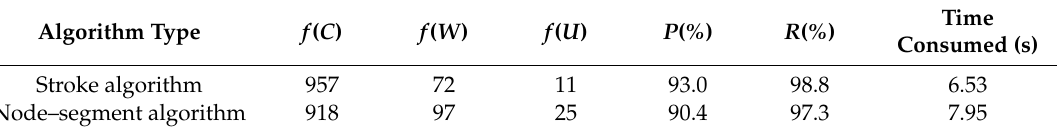
Table 4. Comparison of the experimental results using two